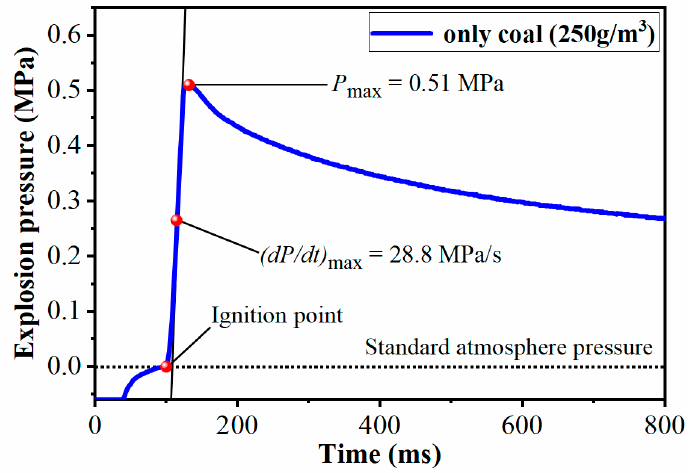
Figure 6. Explosion pressure time history. Table 3. The maximum explosion pressure ( P max ) (MPa) of mixed dust.